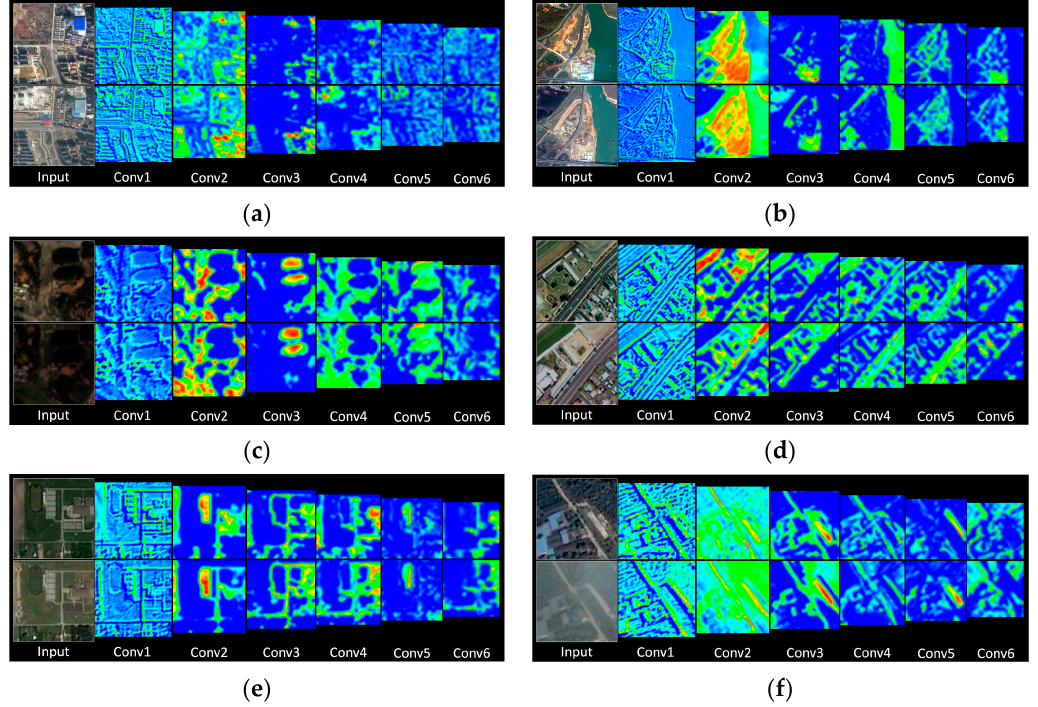
Figure 8. Examples of feature visualization learned by the proposed SCNN. ( a ), ( b ), ( c ), ( d ), ( e ) and ( f ) are the visual features in Pair1, Pair2, Pair3, Pair4, Pair5 and Pair6 respectively.